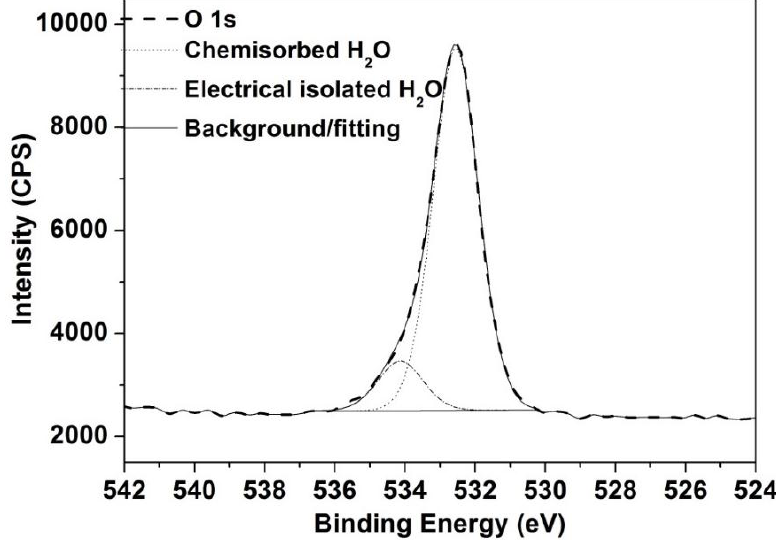
Figure 5. Fitted O 1s spectrum collected from the chalcopyrite slab in contact with pyrite (galvanic cell) leached at 750 mV, 75 °C and pH 1.0 for 30